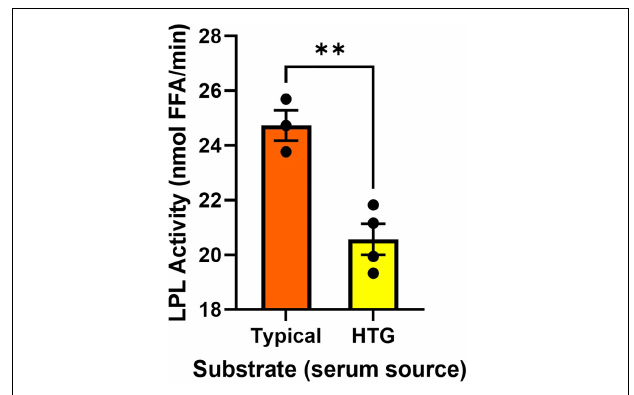
FIGURE 4 | Serum activation/inhibition of a known LPL source. ** P <